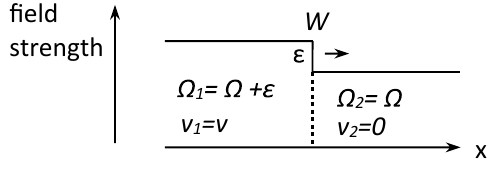
Fig. 3. A perturbation propagating in a stationary